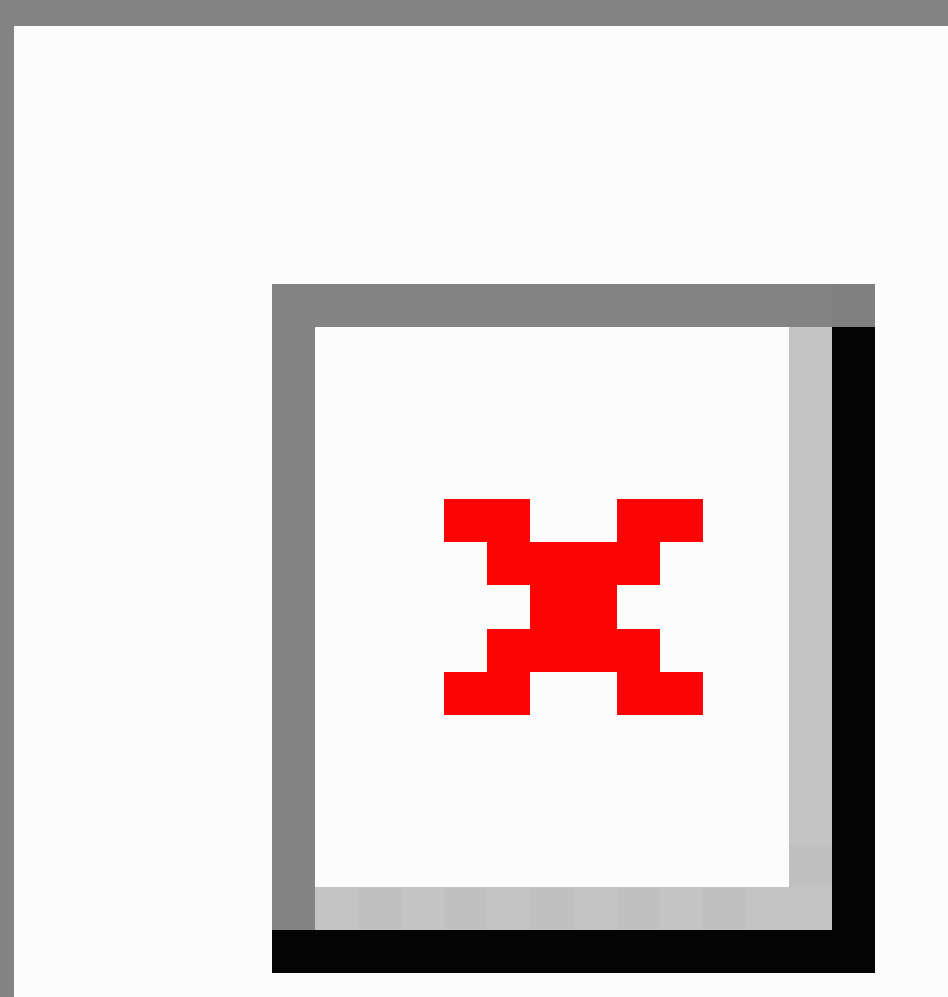
Figure 2. Recruitment and enrollment rate of participants to Anxiety Online (AO)